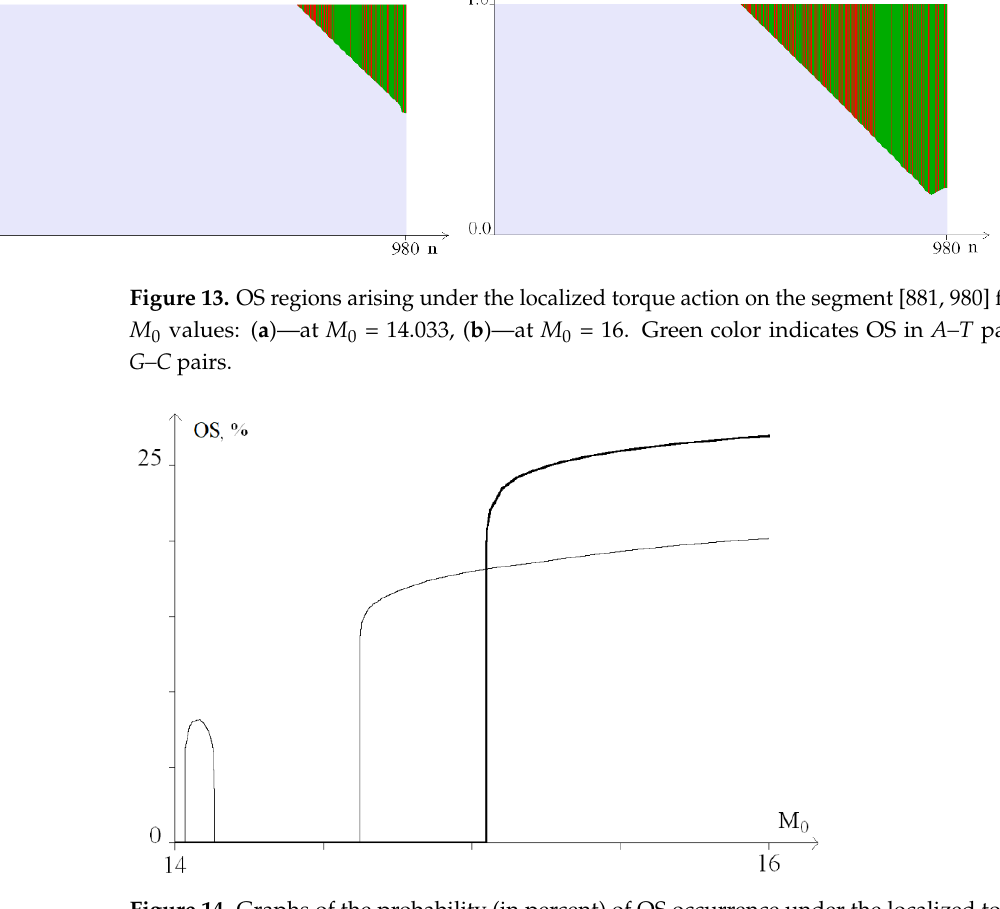
Figure 14. Graphs of the probability (in percent) of OS occurrence under the localized torque action on the segment [781, 880] (thin line) and the segment [881, 980] (thick line). shown at the highest M 0 value, which does not lead to OS.